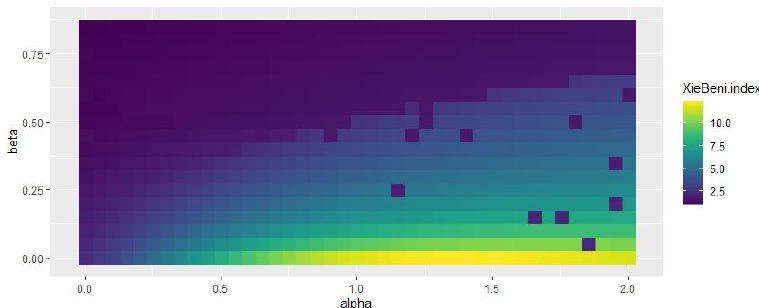
Figure 8. Influence of beta and alpha values on Xie and Beni index.